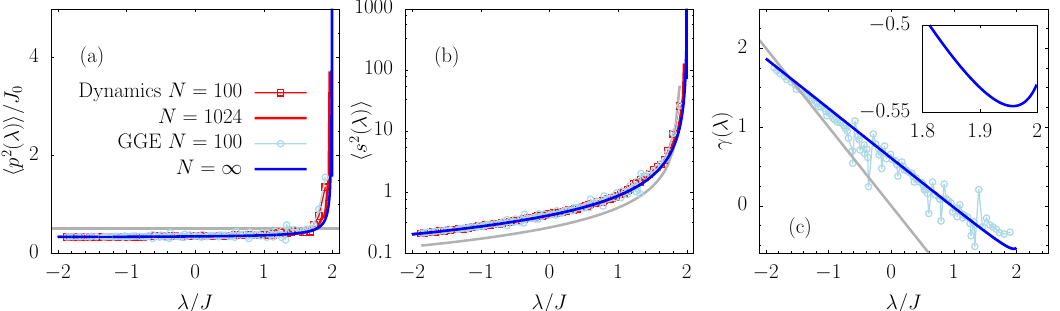
= 0.5 J and J = 0.4 J . (a) 〈 p 2 ( λ ) 〉 , 0 0 0